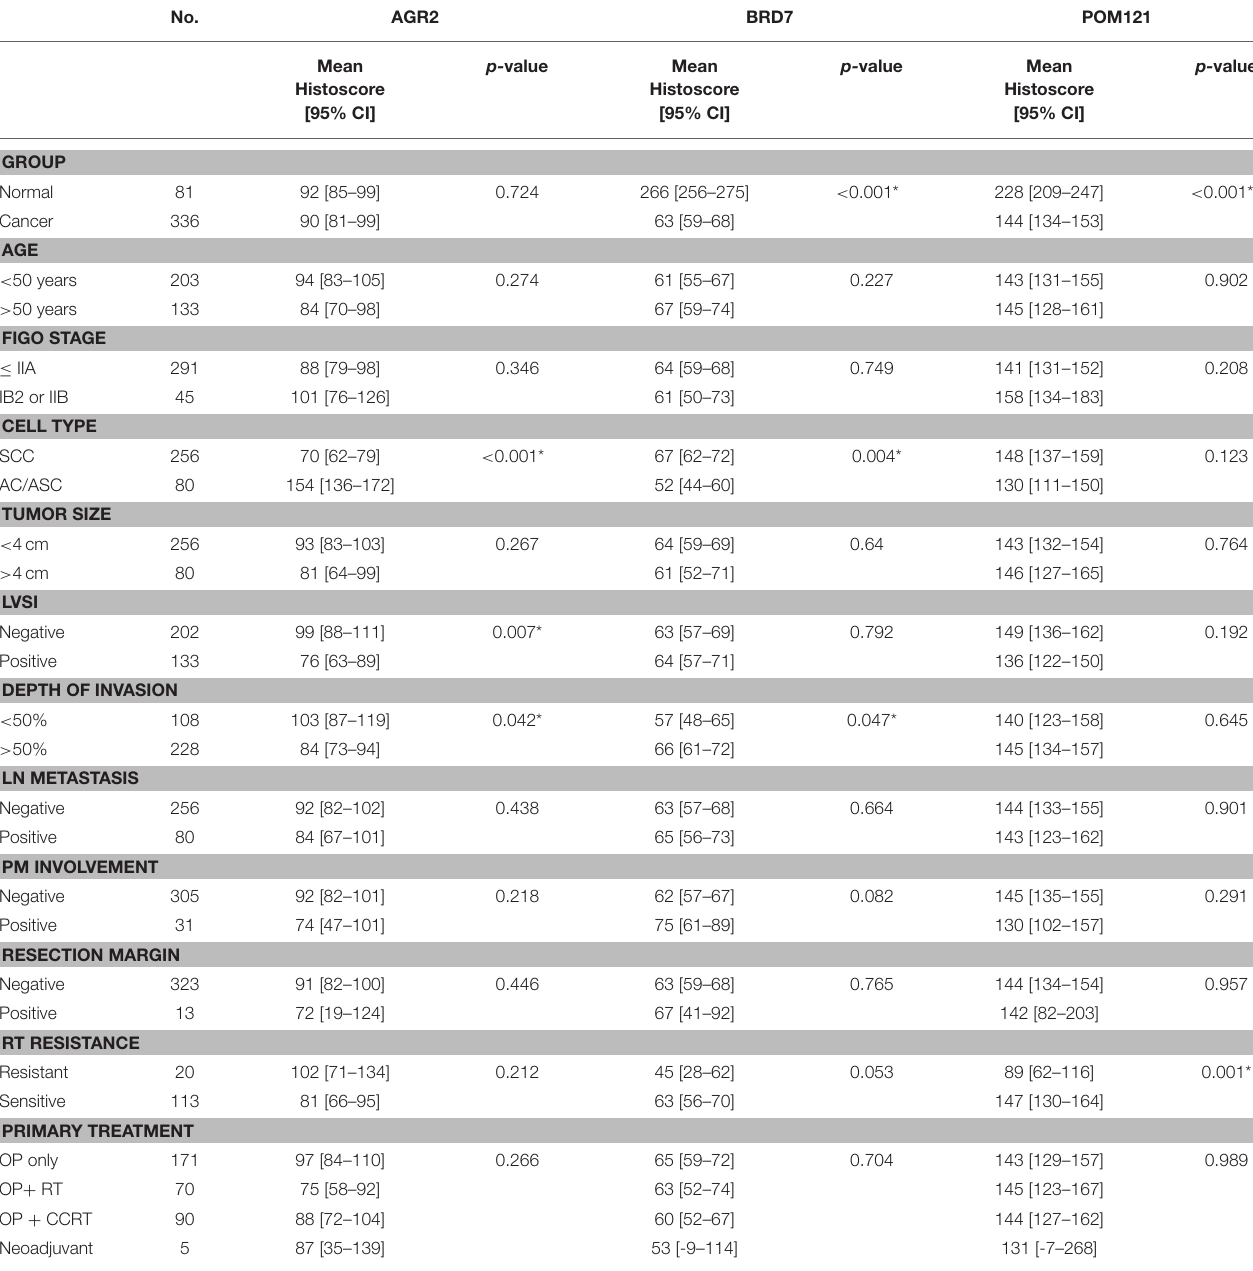
FIGO,InternationalFederationofGynecologyandObstetrics;SCC,squamouscellcarcinoma;AC,adenocarcinoma;ASC,adenosquamouscellcarcinoma;LVSI,lymphovascularspace invasion; LN, lymph node; PM, parametrium; OP, operation; RT, radiotherapy; CCRT, concurrent chemoradiation. * Significant at the level of p <